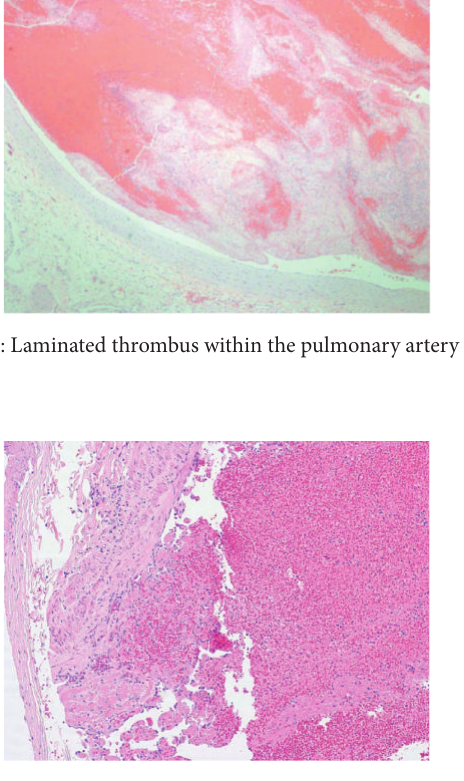
Figure 5: Focal endothelial organization within the left leg vein (H&E